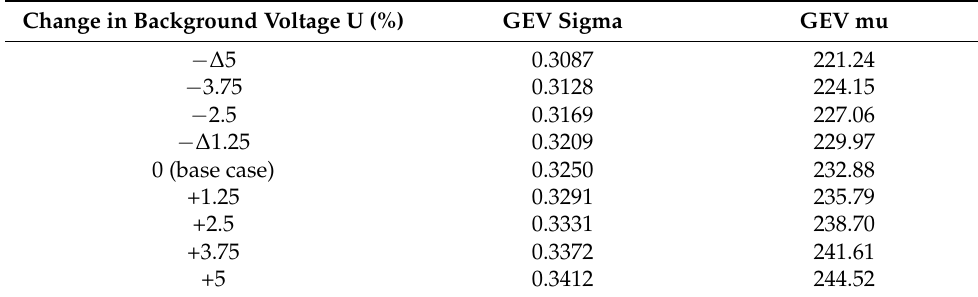
Table 2. The change in background voltage input parameters showing the standard deviation and mean for the GEV with the same shape (k = −0 .0309).